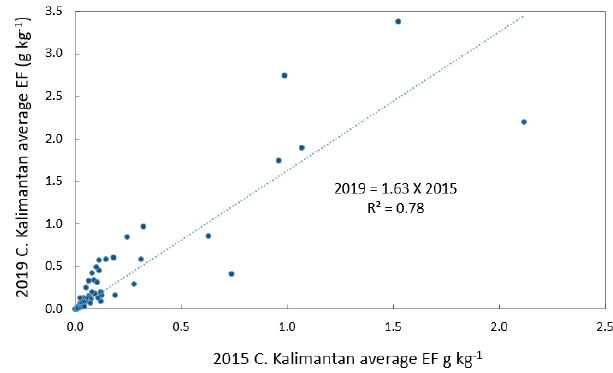
Figure 5. NMOG EFs (gkg − 1 ) measured in 2019 in Central Kali- mantan (this work) versus NMOG EFs measured in Central Kali- mantan in 2015 by Stockwell et al. (2016a).